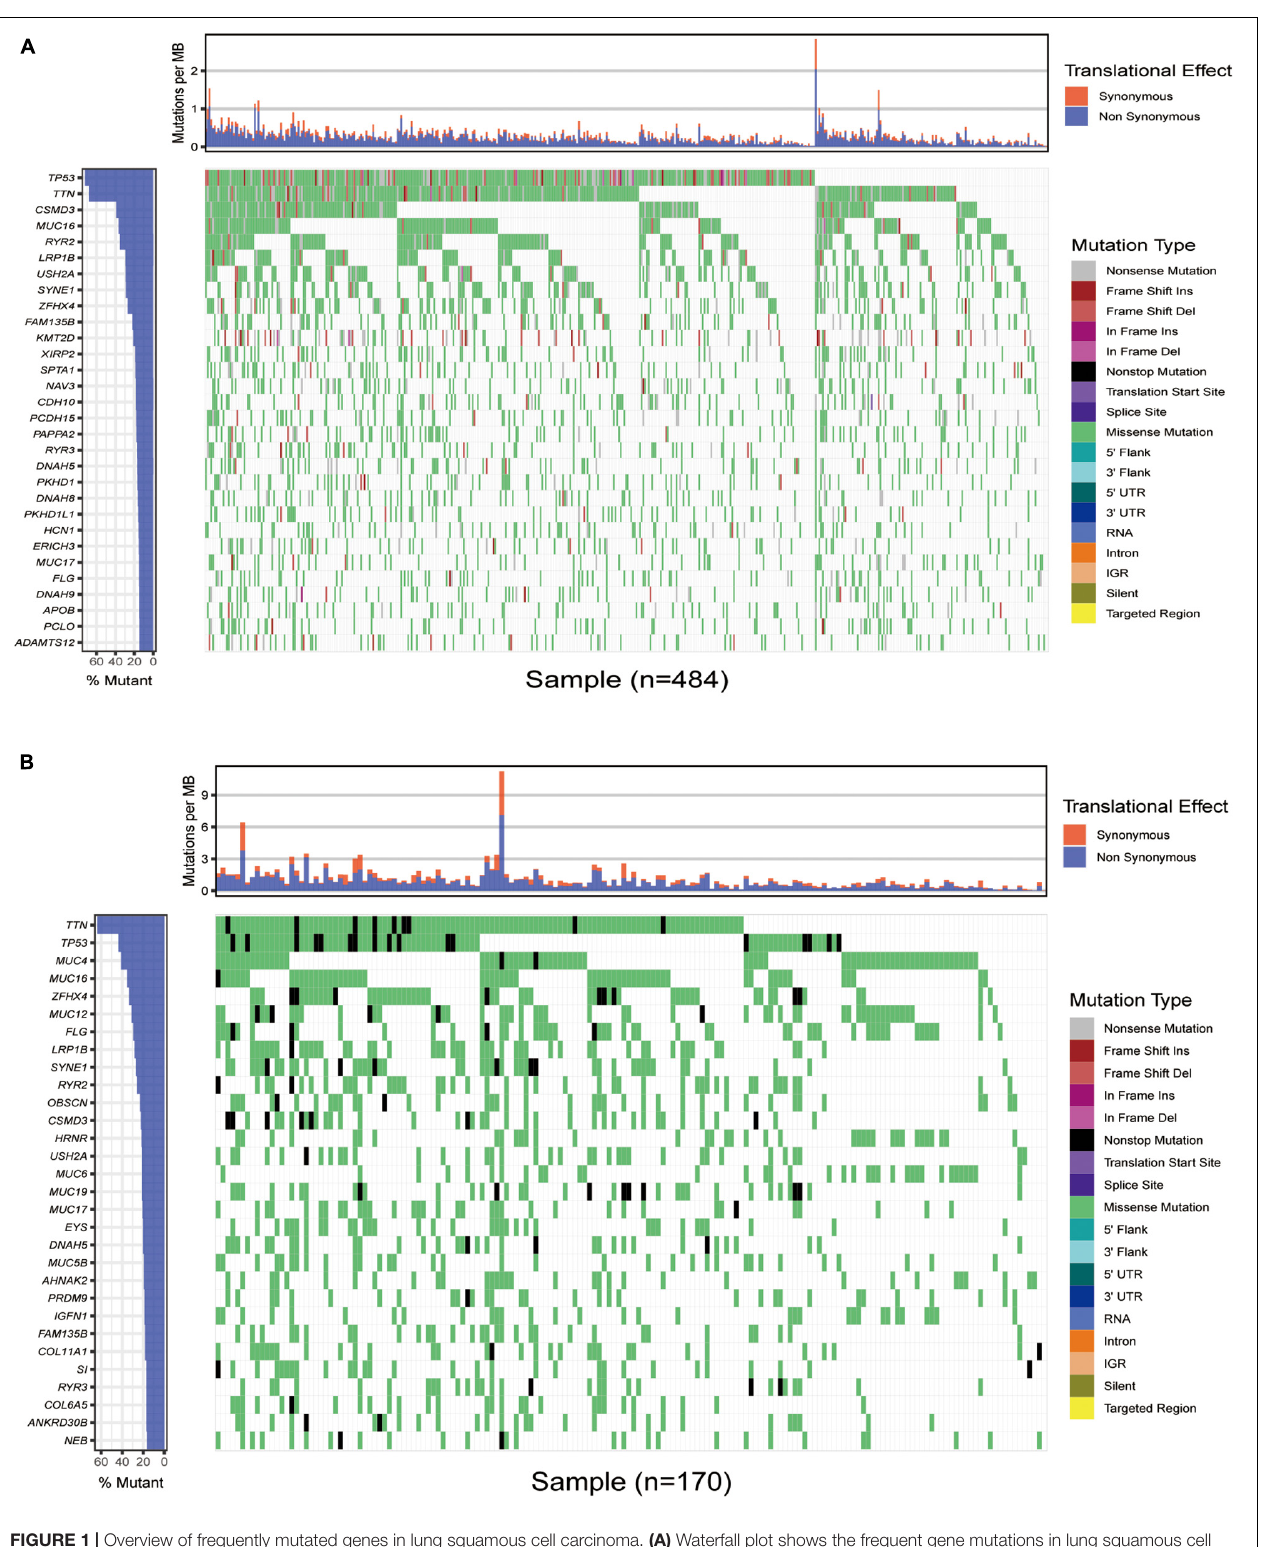
FIGURE 1 | Overview of frequently mutated genes in lung squamous cell carcinoma. (A) Waterfall plot shows the frequent gene mutations in lung squamous cell carcinoma from The Cancer Genome Atlas (TCGA) database. The left panel presents the frequency of gene mutation according to which genes are sequenced. The right panel displays diverse mutations. (B) Waterfall plot displaying the frequent gene mutations in lung squamous cell carcinoma from the International Cancer Genome Consortium (ICGC) cohort. The left panel exhibits the genes sequenced via the frequency of gene mutation. The right one displays diverse mutations.